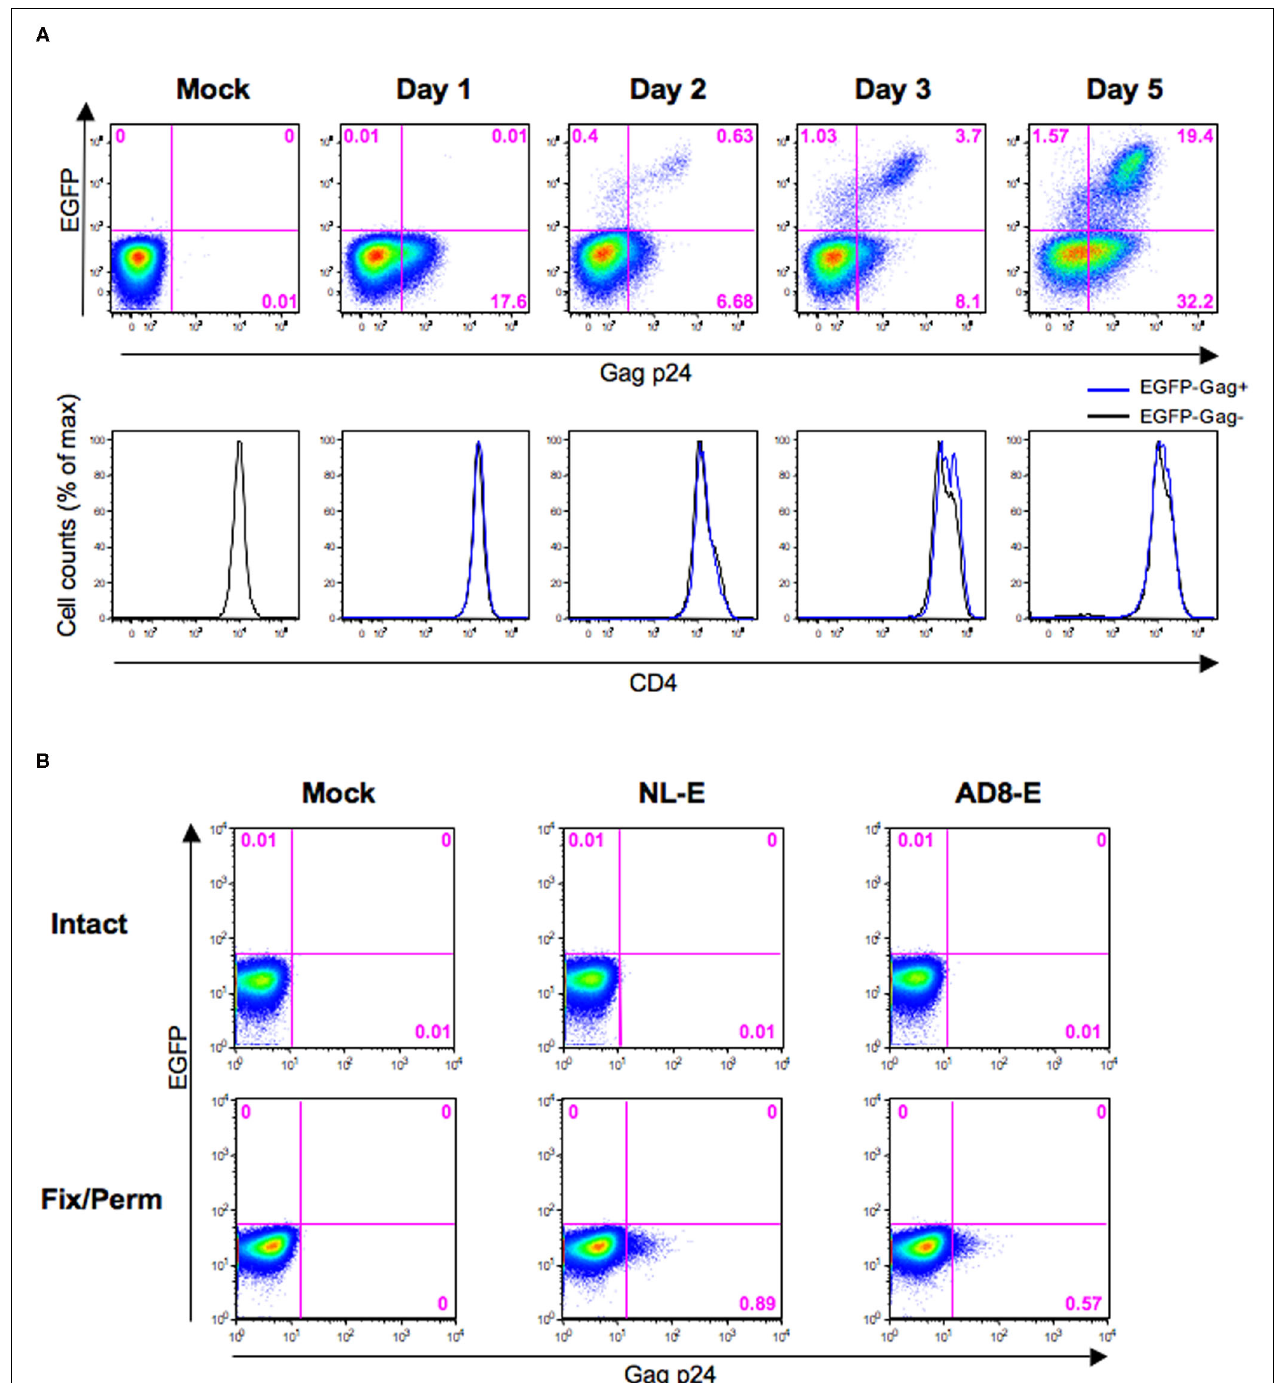
FIGURE 5 | Evaluation of Gag p24 ICS for HIV-1-internalized and -bound cells. (A) Representative flow cytometric analyses of the HIV-1 NL-E infection (NL-E) and mock (Mock) groups from three donors in which unstimulated primary CD4 + T cells were infected with HIV-1 NL-E or not, respectively, and cultured for 5days (including the initial 1day culture with TCR-stimulation).The expression patterns of EGFP and Gag p24 are indicated in the pseudo-color plot profiles for the Dead − /CD3 + /CD8 − -gated